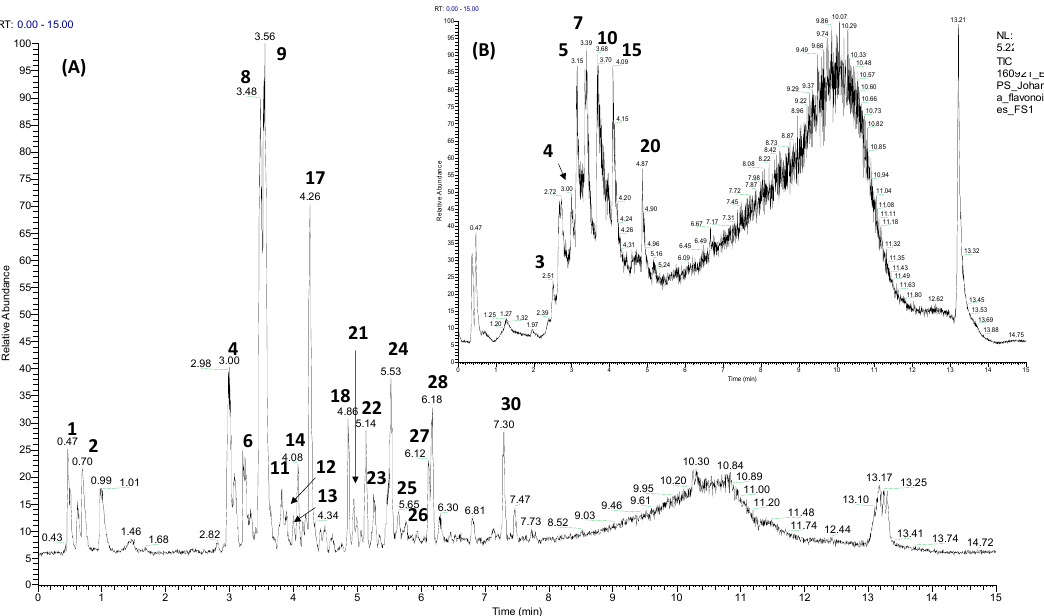
Figure 2. UPLC-TIC (ultra HPLC total ion current) chromatograms of ( A ) the phenolic-rich seed extract (PSE), and ( B ) F3S fraction. Peak numbers refer to those indicated in Table 2.